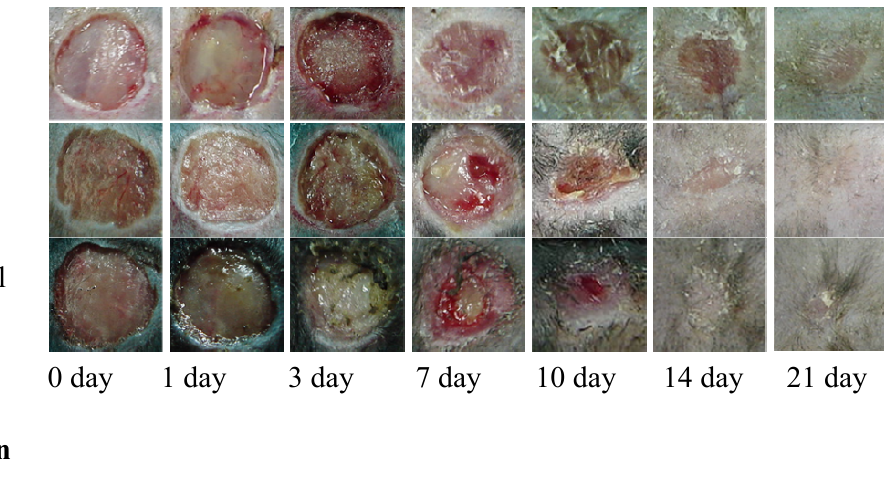
Figure 10. Wound image of the control, commercial medicine, PAAc nanogel paste, Ag/PAAc nanogel paste after one, three, seven, 10, 14, 21 days